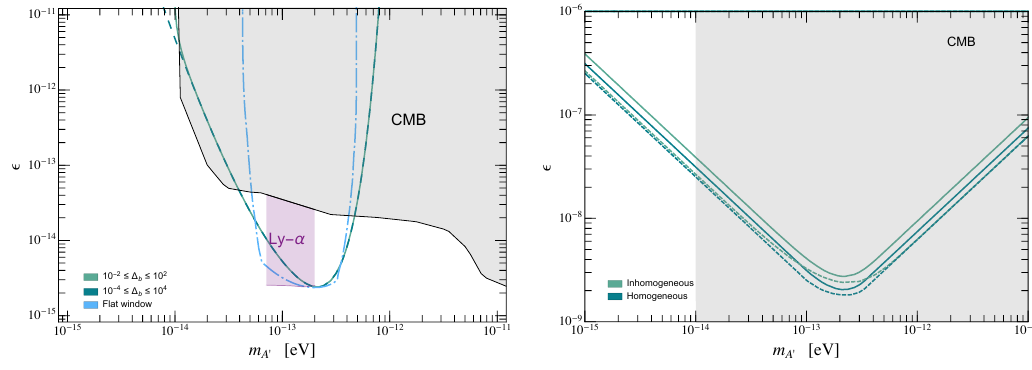
Figure 4 . Left: constraints from Ly- (cid:11) observations between 2 . z . 6; obtained by requiring " Ly- (cid:11) < 0 : 5 eV/baryon, as de(cid:12)ned in eq. (3.1). Constraints are derived assuming the PDF of (cid:1) b is log-normal and is valid in the range 10 (cid:0) 2 (cid:20) (cid:1) b (cid:20) 10 2 or 10 (cid:0) 4 (cid:20) (cid:1) b (cid:20) 10 4 , and using two di(cid:11)er- ent sensitivity functions as divided in eq. (3.2) (blue) and eq. (3.3) (green). These constraints are compared with those derived from the CMB (grey) and Ly- (cid:11) forest (purple) assuming a homoge- neous Universe (as derived in ref. [21]). Right: non-resonant constraints derived with and without inhomogeneities, and including (solid) and excluding (dashed) the default sensitivity function in eq. (3.3). Grey region denotes parameter space excluded using the CMB [21]. (cid:12)rst excited state (this is also known as the \21cm" transition). The goal, simply put,